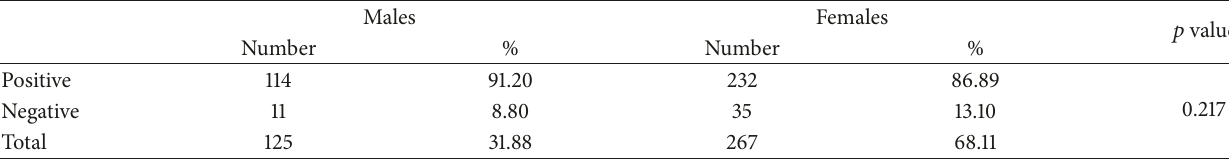
Table 1: Distribution of foot mycosis according to